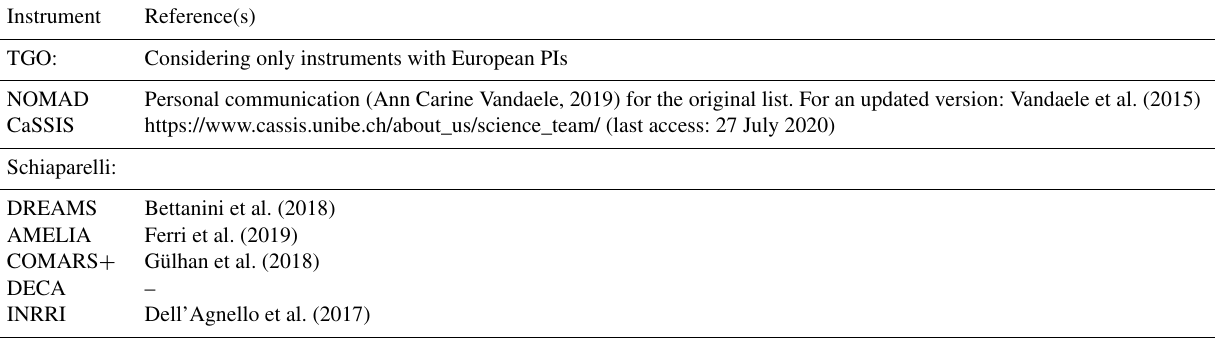
Table A10. ExoMars’s instruments and references for team members lists.